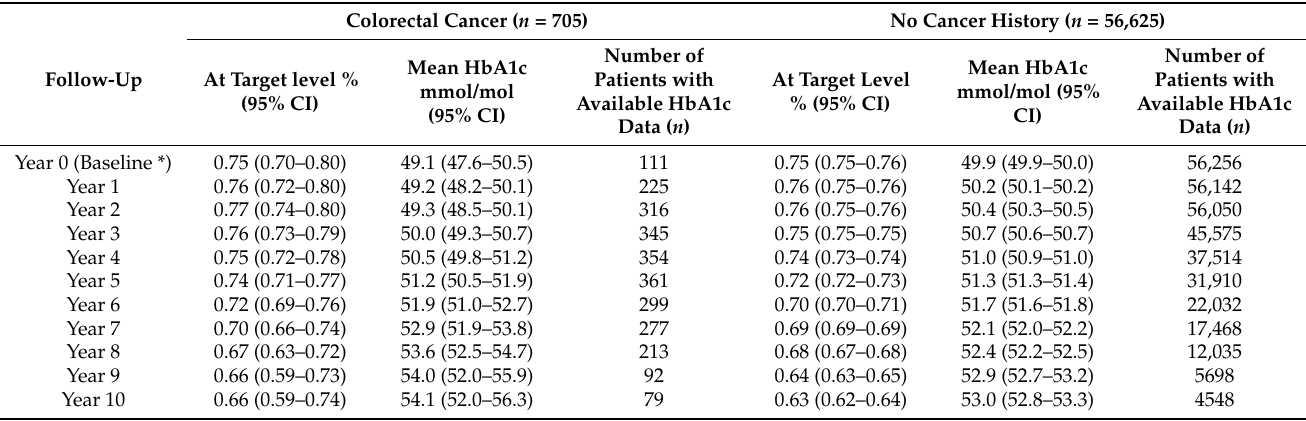
Table 2. Estimated quality of glycemic control during follow–up.